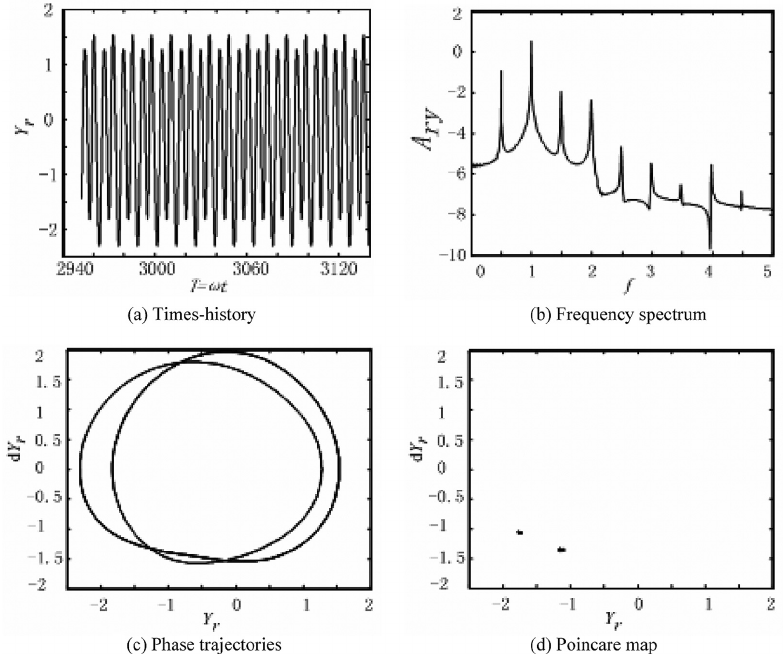
Fig. 6. Characteristics of the system when ω = 240rad/s (with the pad moment of